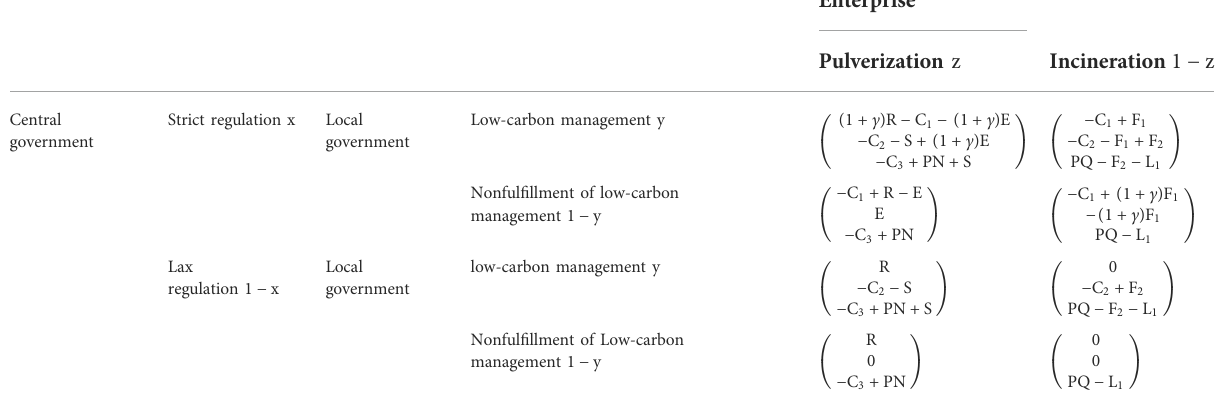
TABLE 1 Payoff matrix for the tripartite